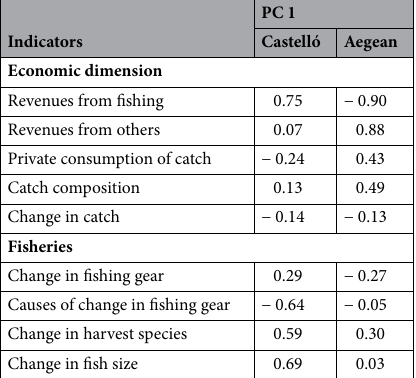
Table 4. Component matrix for the sensitivity indicators from PCA